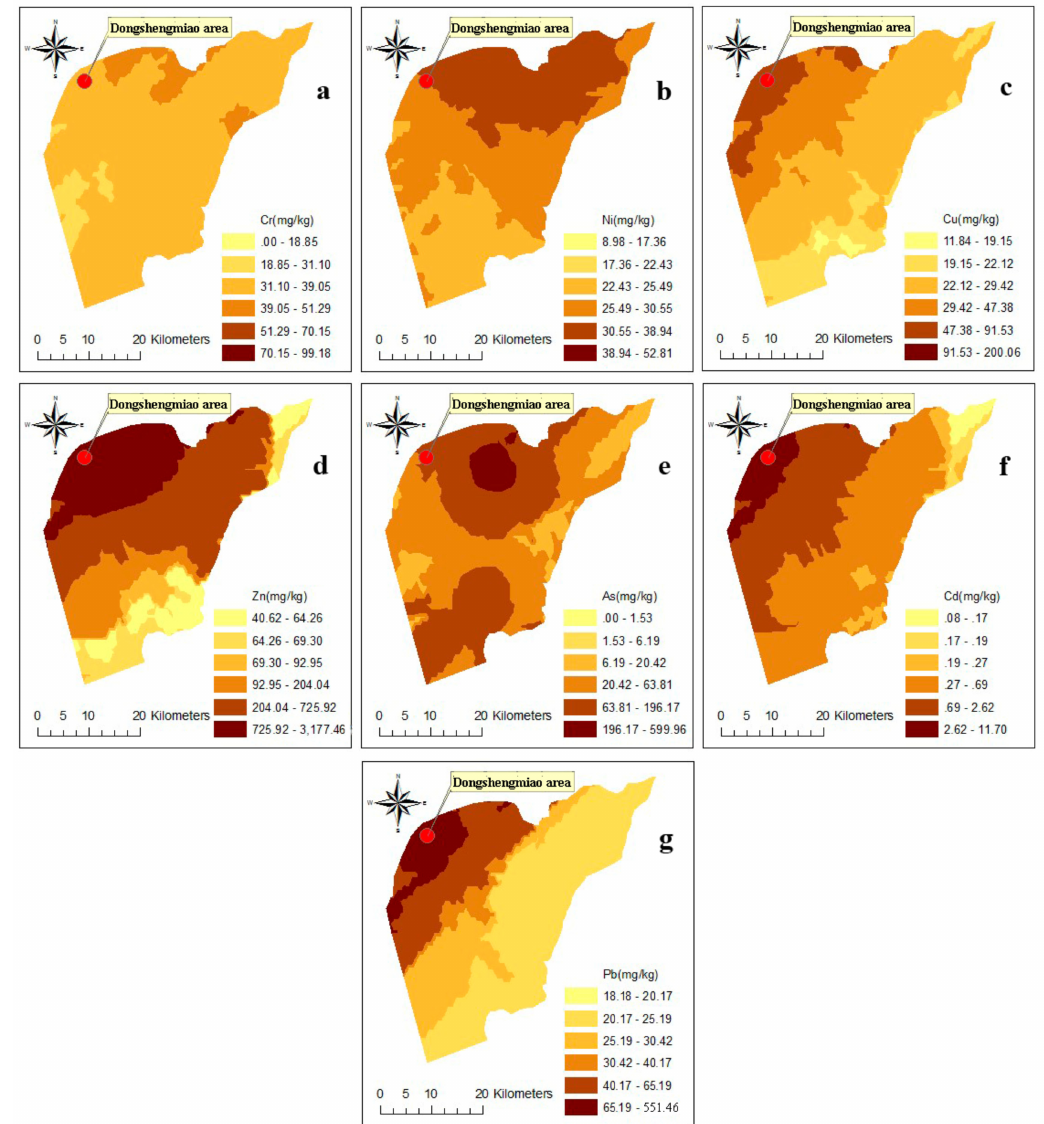
Figure 4. Spatial distribution of arsenic and heavy metal accumulations in soil in the Dongshengmiao mining area: ( a ) Cr, ( b ) Ni, ( c ) Cu, ( d ) Zn, ( e ) As, ( f ) Cd, and ( g )